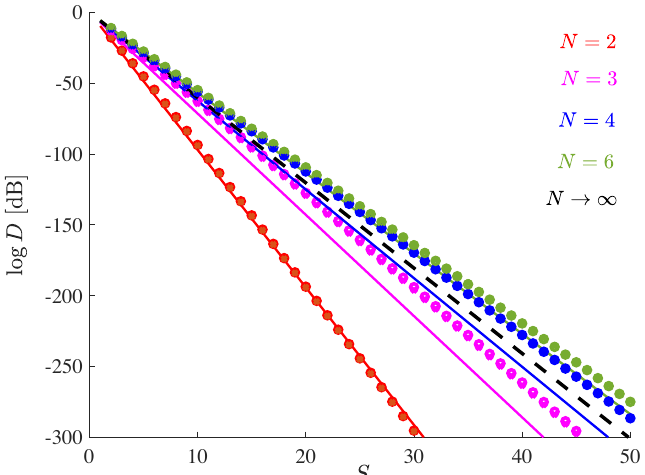
Figure 4. Median total squared error D for target matrix of unit Frobenius norm vs. the parameter S (approximately the total number of additions per column required for all wiring matrices). The solid lines refer to m S , the markers to simulation results. Circles and crosses are for IID Gaussian ε 2 codebook matrices and mailman codebooks, respectively, all with unit rate. IID Gaussian target matrices. Results are averaged over 10 6 random matrix